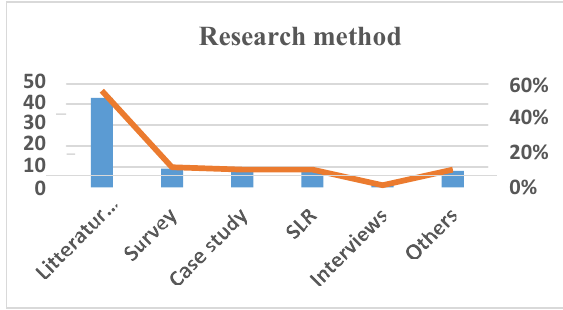
Fig 5. Classification by research method